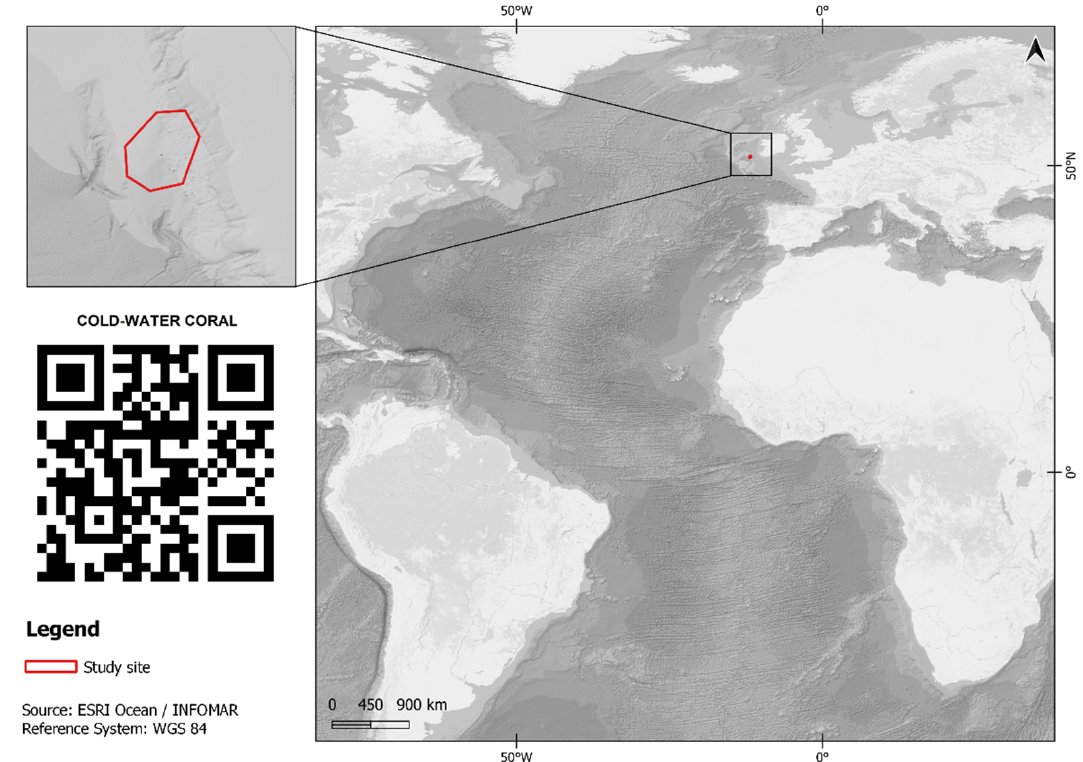
Figure 8. Interactive map for the AR app visualisation. After downloading the APP (APK) on their phone, the user can open app and scan the QR Code (left) on the map.